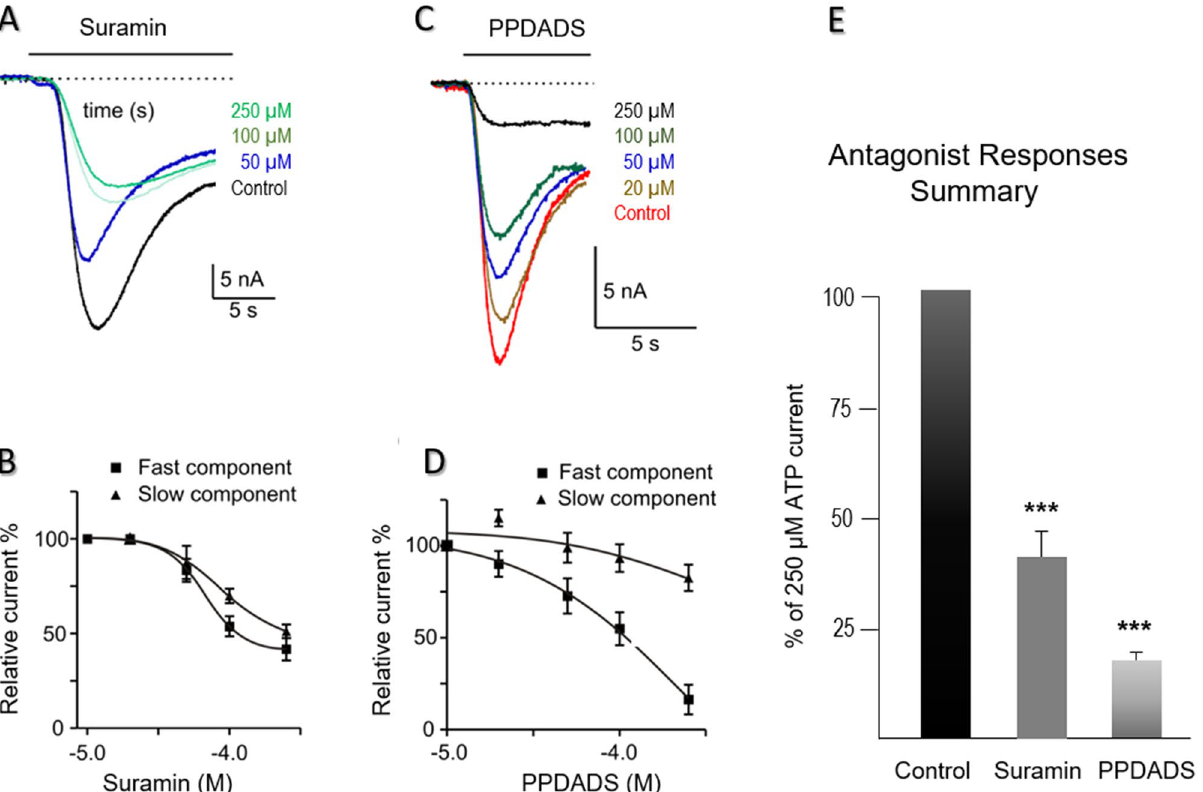
Figure 4. Pharmacology of Ac P2X receptors in Xenopus oocytes. ( A ) Example of currents induced by 250 μM ATP. ATP was applied to oocytes for 15 s, in the presence of varying concentrations of suramin (HP = − 70 mV). ( B ) Mean responses to 250 μM ATP in the presence of 1–250 μM suramin. There was a suramin-resistant component of the Ac P2X current. Symbols represent mean ± S.E n = 7, oocytes). ( C ) Traces recorded in response to 250 μM ATP in the presence of varying concentrations of the second antagonist, PPADS (concentrations are shown in μM, and all applications are indicated by the solid lines) (n = 7, oocytes). ( D ) Mean responses to 250 μM of ATP in the presence of the PPADS (a fast component of responses—closed squares, slow component—triangles). PPADS was an effective antagonist in the range of 1–250 μM. Fitting of the data using the sigmoidal dose–response curve by a continuous line, IC50 fast = 211.2. Symbols represent the mean ± S.E (n = 7, oocytes). ( E ) The suramin proved to be a more effective blocker of the ATP-activated channels among the two antagonists tested. A chart of mean currents (% of 250 µM ATP response) in the presence of 250 µM Suramin and 250 µM PPADS. Mean currents were normalized to the response given by 250 μM of ATP. Symbols represent mean ± S.E; statistically significant differences (Student’s t -test) from control (P < 0.05) are indicated by asterisks (***) above the bars (n = 7, other P2X receptor subunits. The response to 250 µM ATP produced a mean peak amplitude of 31.3 nA ± 3.8 nA and a time to a peak value of 2.76 ± 0.21 s (n = 19) with a holding membrane potential of − 70 mV (Fig. 3C). The ATP analog, 2 ′ ,3 ′ -O-(4-Benzoylbenzoyl) adenosine 5 ′ -triphosphate (Bz-ATP 34 ) gave a partial response at 20% of the ATP response (n = 8, oocytes, Fig. 3C). There were no UTP and ADP responses within the same range of concentrations (data not shown). The current–voltage relationship was investigated in the presence of elevated (144 mM) and low extracellular NaCl (96 mM) concentrations (n = 6, oocytes, Fig. 3D). A reversal potential was determined by applying a ramp protocol from − 70 to 20 mV in high and normal Na + with 250 µM of ATP (Fig. 3E). According to the Nernst equation, the reversal potential was 13.9 mV and shifted by + 10.2 ± 1.3 mV to positive holding in high sodium solution (n = 6, oocytes). P2X antagonist suramin 34 inhibited ATP responses in a concentration-dependent manner (Fig. 4A,B; n = 7, oocytes). Another P2X antagonist, pyridoxal-phosphate-6-azophenyl-2 ′ ,4-disulfonic acid (PPADS 34 ), also inhib- range of 1–250 µM PPADS generated an IC50 = 211.2 µM for the fast component, but the slow component could not be calculated (n = 7, oocytes, Fig. 4D). The second splice form of AcP2X b was also expressed in oocytes pro- ducing currents very similar to the first isoform AcP2X described above; however, it resulted in much smaller (and unstable) responses (data not shown).